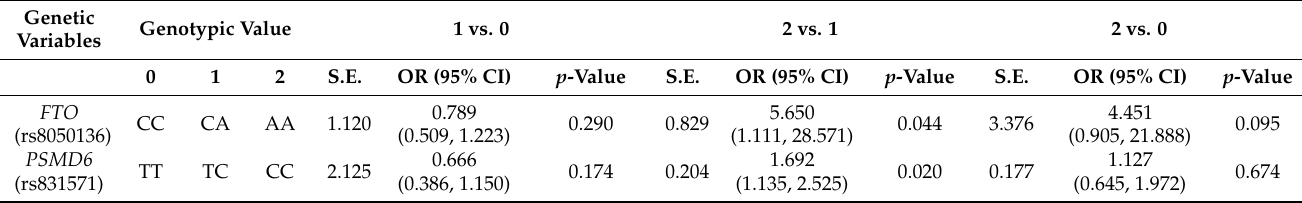
Table 2. Backward stepwise regression analysis on the association between SNPs and diabetic retinopathy using the additive model.